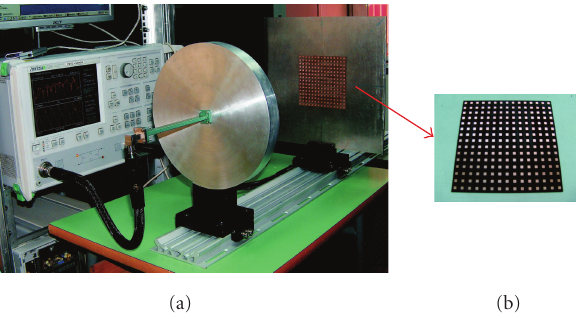
Figure 8: Photograph of (a) open resonator system and (b) realized reflecting surface.